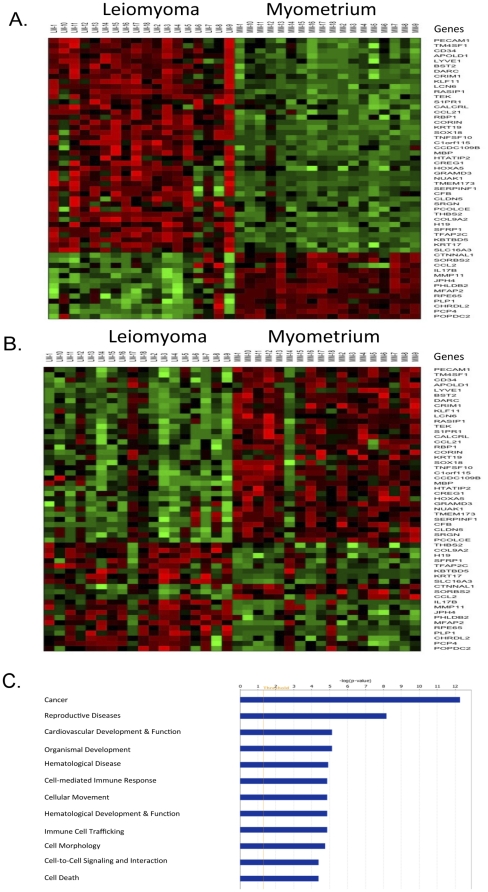
Differential patterns of DNA methylation and mRNA expression in uterine leiomyoma and matched myometrial tissues.Overall, 36 samples from 18 subjects were analyzed; 18 samples were obtained from leiomyomas and 18 from adjacent matched myometrial tissues. (A) The DNA methylation profile shows that most of the samples exhibit a very homogeneous DNA methylation pattern. (B) The gene expression profile exhibits a less homogeneous pattern, which could be due to mRNA instability. (C) Functional analysis of the 55 genes with correlation between DNA methylation status and mRNA expression showed that the top two functions represented are cancer processes (P<10−12) and reproductive system disease (P<10−8).